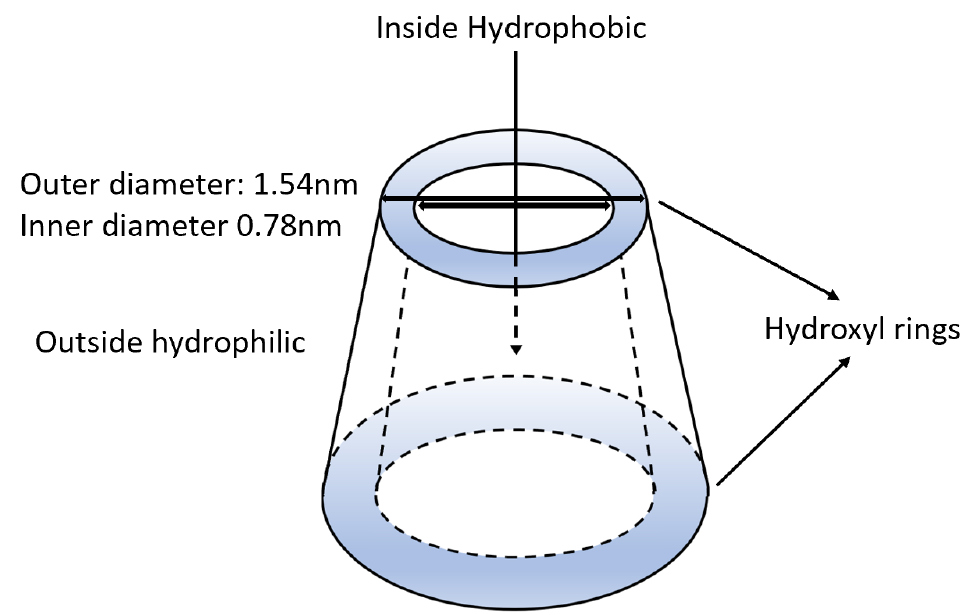
Figure 1. An illustration of the beta-cyclodextrin functionality and dimensions.